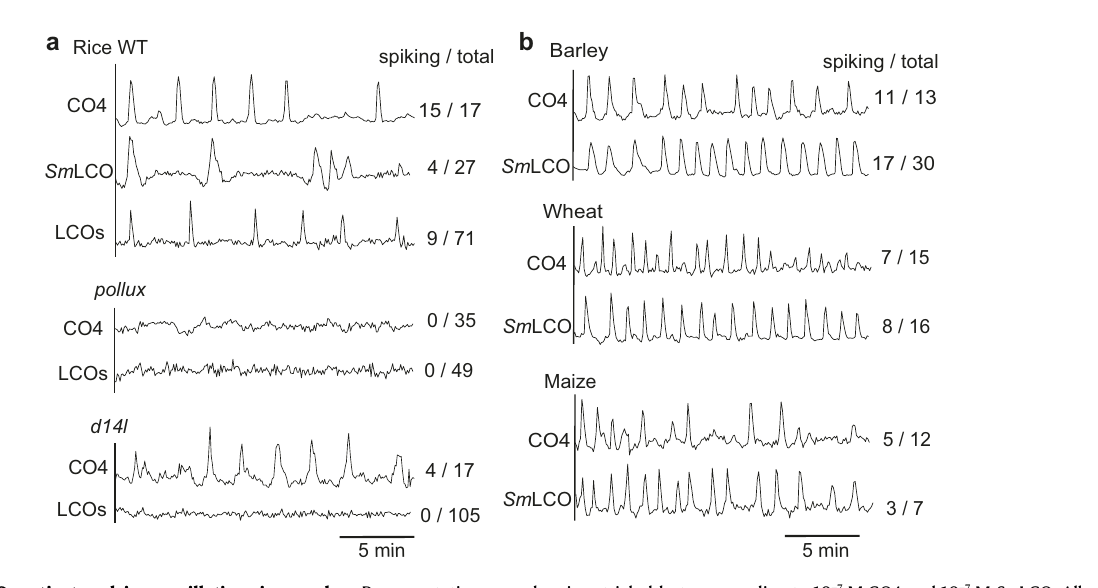
and maize atrichoblasts responding to 10 − 7 M CO4 and 10 − 7 M Sm LCO. All plants weregrownundernutrientde fi cientconditions.Numbersindicatecellsresponding compared to total cells analyzed.